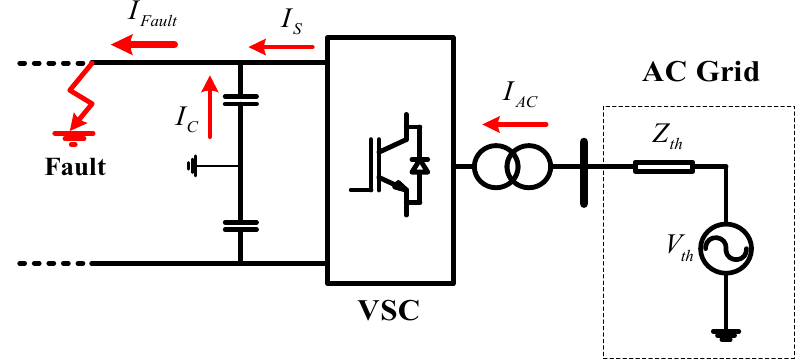
Figure 1. Fault occurrence in the high voltage direct current (HVDC) line.